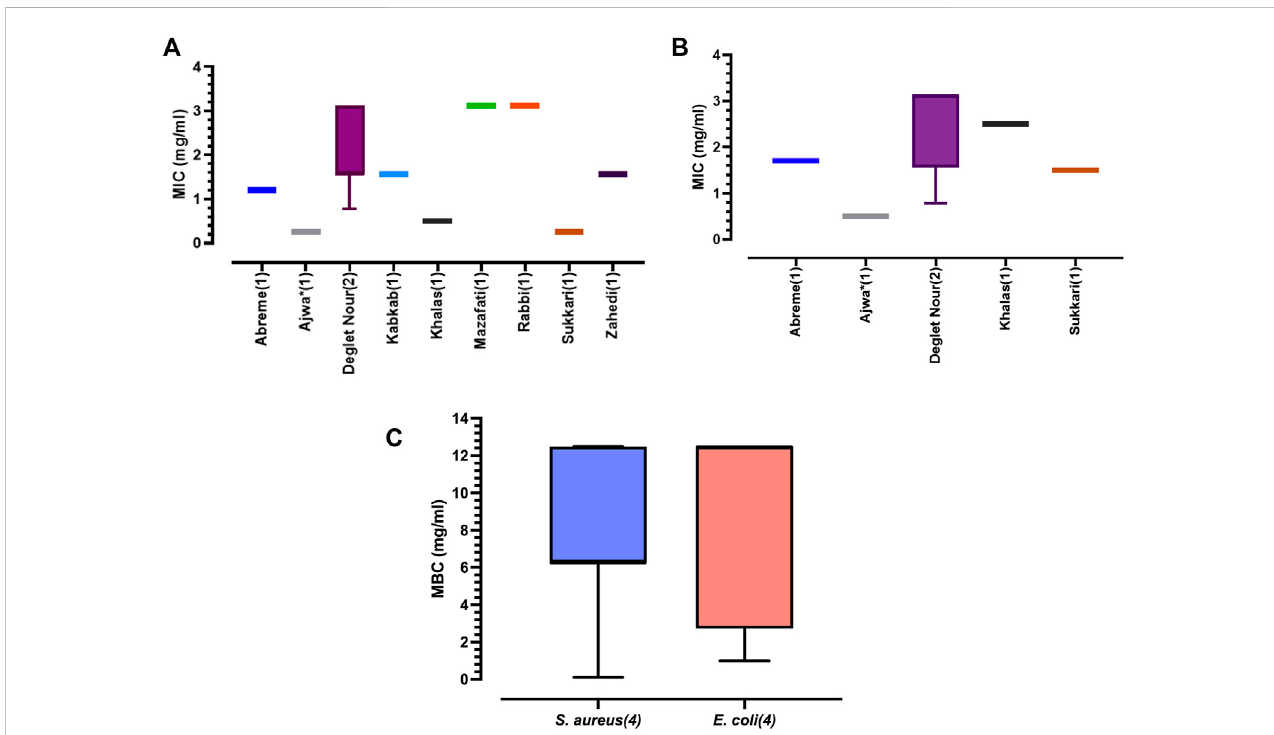
FIGURE 5 (A) Boxplot of pooled median ± range of minimum inhibitory concentration (MIC) results reported against S. aureus in included studies (values in parentheses indicate number of studies). *Gallic acid was isolated from the date seed extract and used for the test. (B) Boxplot of pooled median ± range of minimuminhibitoryconcentration(MIC)resultsreported E.coli inincludedstudies(valuesinparenthesesindicatenumberofstudies).*Gallicacidwasisolated from the date seed extract and used for the test. (C) Boxplot of pooled median ± range of minimum bactericidal concentration (MBC) results reported against S. aureus and E. coli in included studies (values in parentheses indicate number of